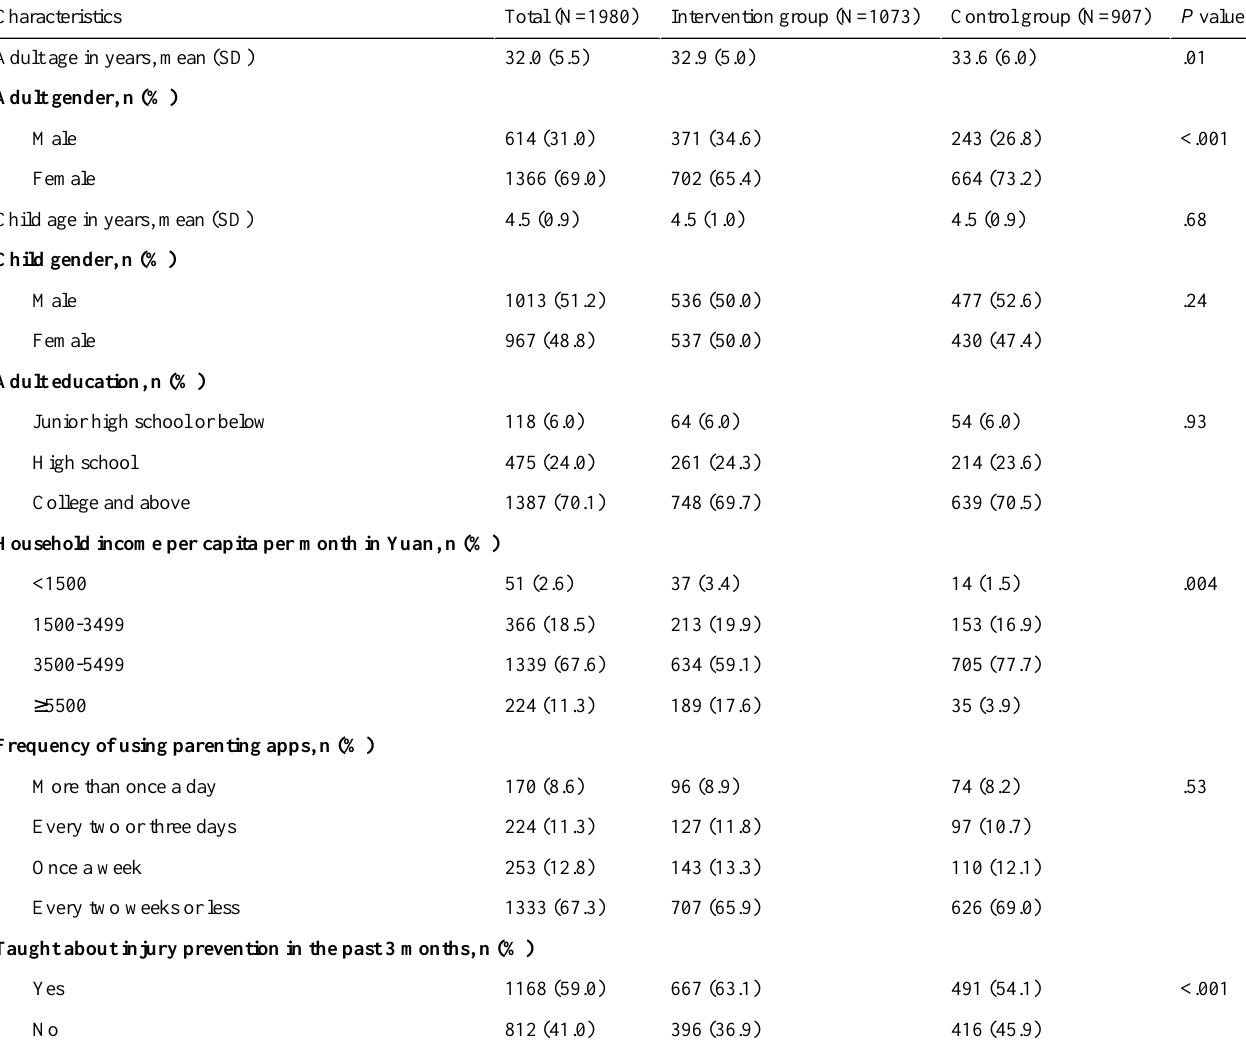
Table 1. Baseline characteristics of study participants who completed baseline surveys and both 3-month and 6-month follow-up surveys.